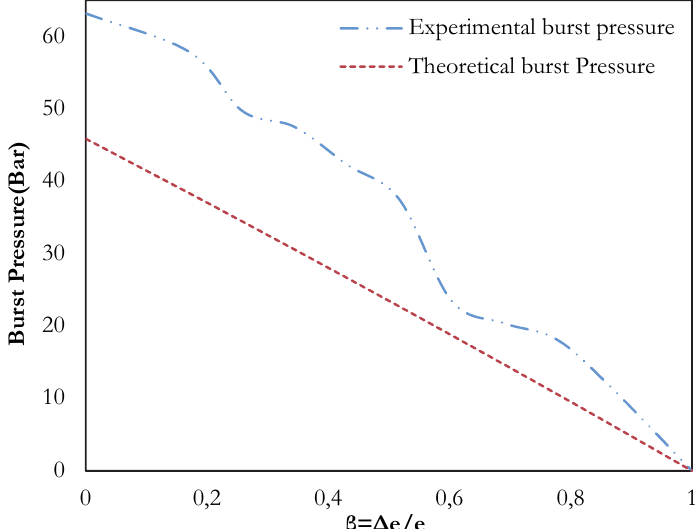
Figure 3: Theoretical and experimental burst pressures as a function of the life